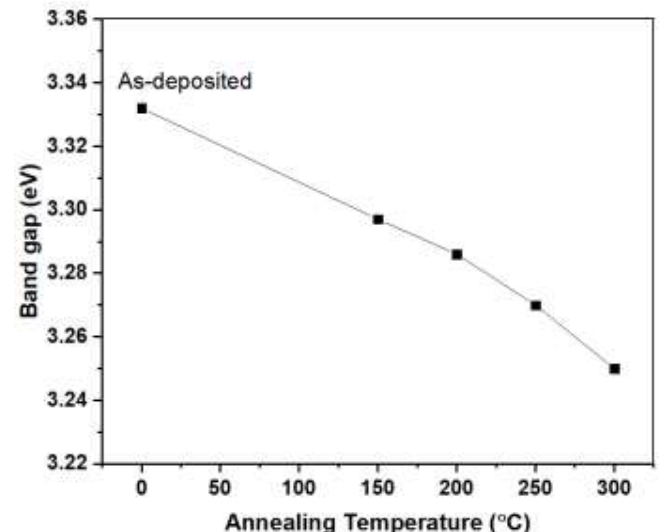
Figure 7: Variation of the bandgap of ZnO film with annealing temperature